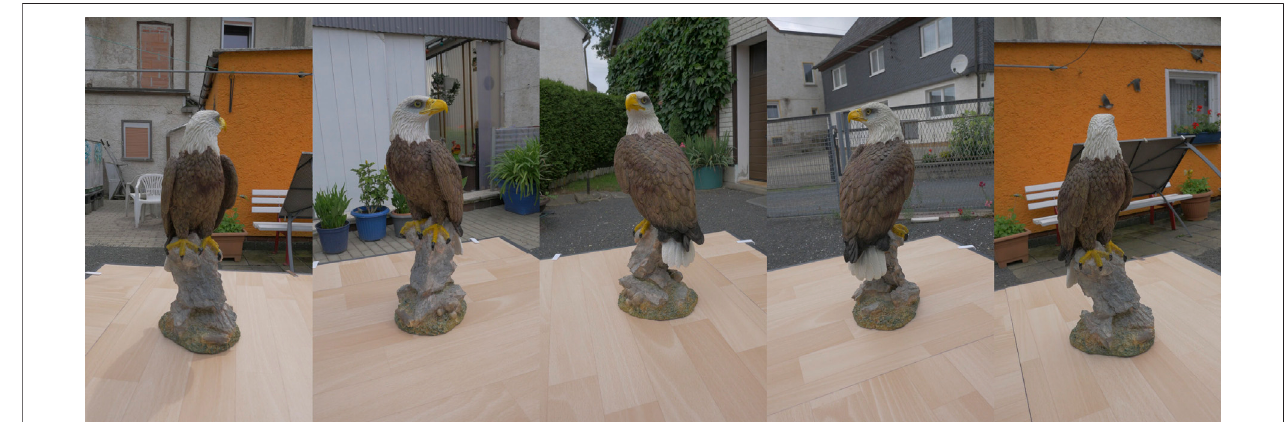
FIGURE 6 | Selected frames of the video used for the cost evaluation.